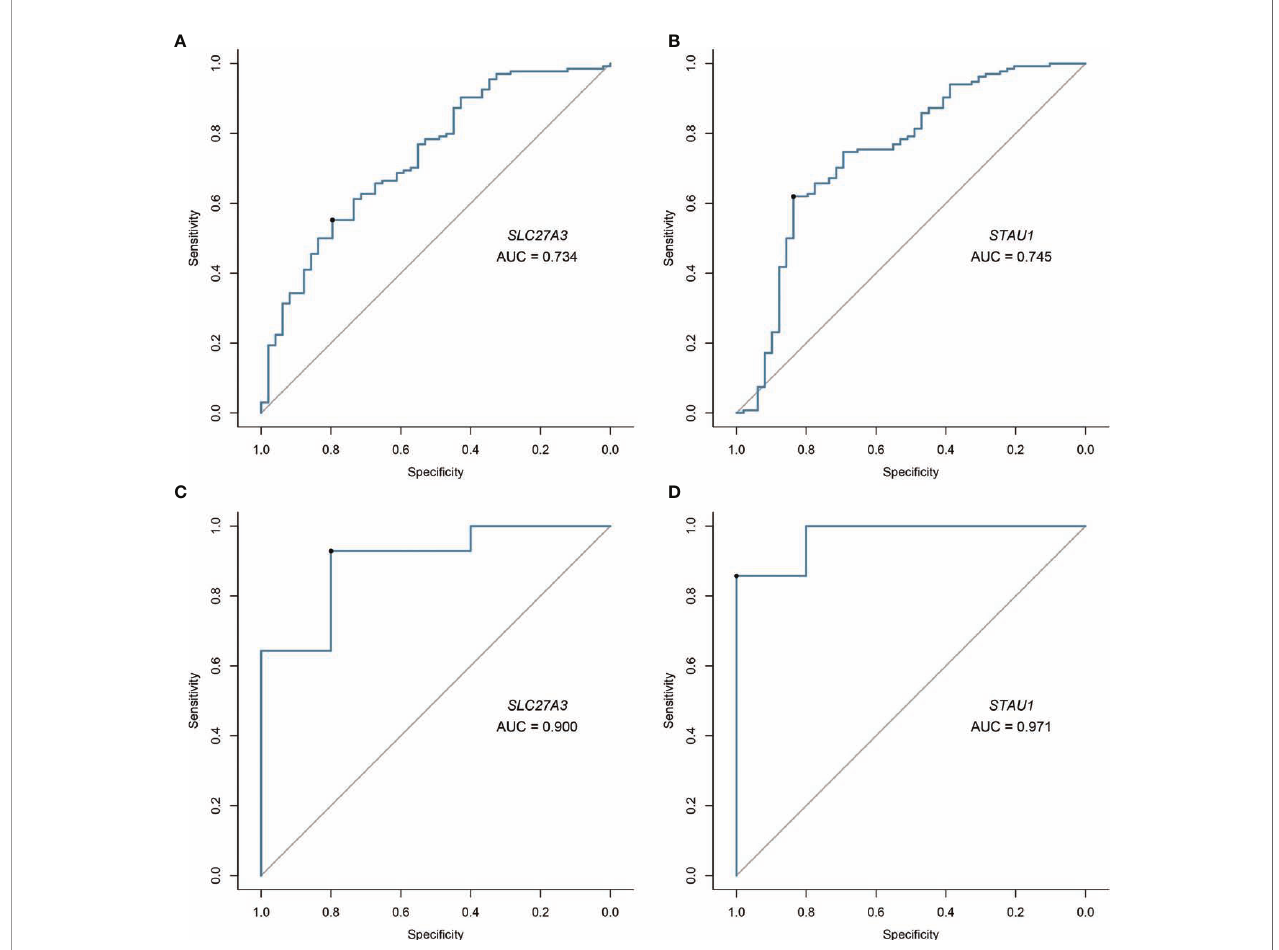
FIGURE 5 | Validation of diagnostic validity of two diagnostic markers. (A, B) Receiver operating characteristic (ROC) curves of SLC27A3 and STAU1 in the metadata cohort. (C, D) ROC curves of SLC27A3 and STAU1 in the GSE106986